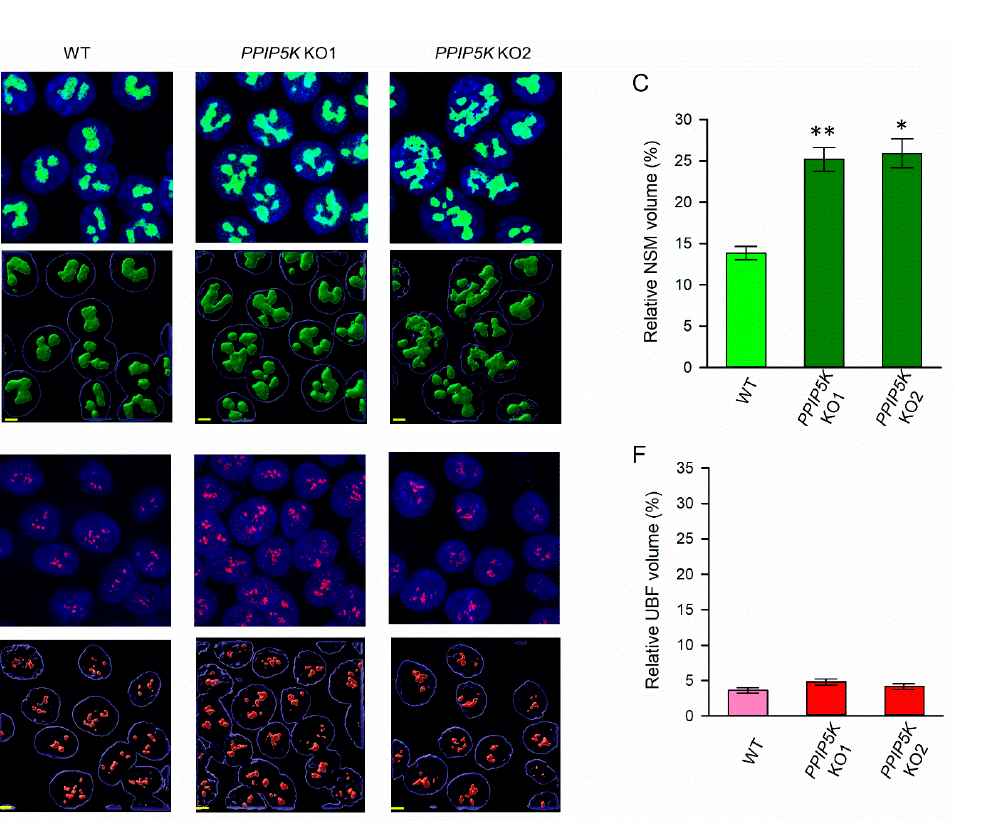
Figure 2. Nucleostemin (NSM) and UBF staining of wild-type and PPIP5K KO HCT116 cells. ( A ) Representative confocal image analysis for staining of nucleostemin (‘NSM’; colored green) in either wild-type (WT) cells or two independent clones of PPIP5K KO cells (KO1 and KO2). ( B ) Three-di- mensional rendering of Z-stacks corresponding to the images in panel A. ( C ) Bar graphs represent means and standard errors from three independent Z-stack datasets (10 fields of view per condition, each containing at least six nuclei). ( D ) , Representative confocal image analysis for staining of UBF (colored red). ( E ) Three-dimensional rendering of Z-stacks corresponding to the images in panel D. ( F ) Bar graphs represent means and standard errors from three independent Z-stack datasets (10 fields of view per condition, each containing at least six nuclei). *, p < 0.05; **, p < 0.02. Scale bars (in yellow) depict 5 µm. The total nuclear volumes (µm 3 ) were estimated from DAPI staining (blue) (means ± standard errors from 6 independent experiments): WT, 3543 ± 151; KO1, 3410 ± 176; KO2, 3457 ± 137.